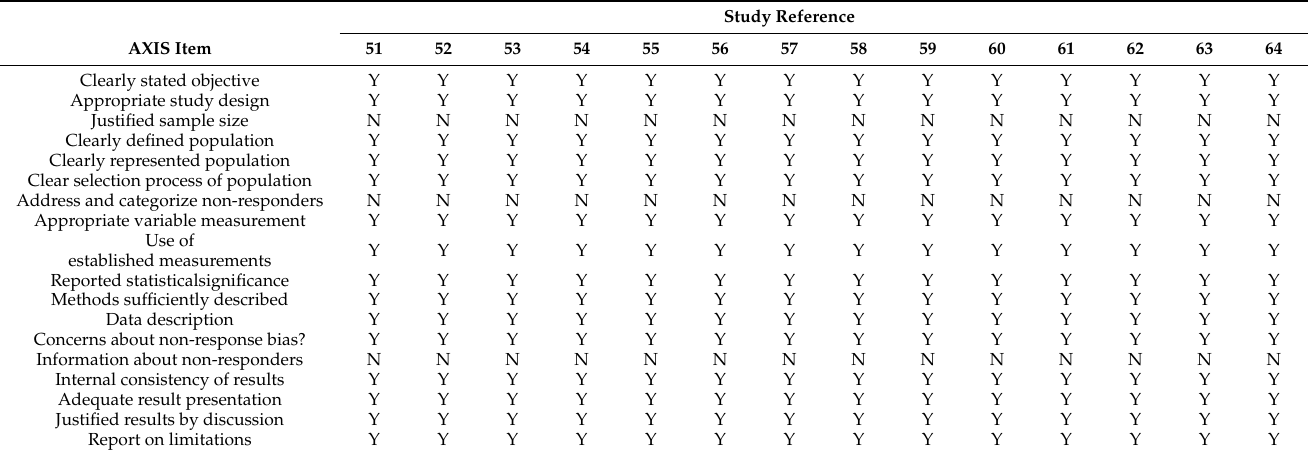
Table 2. Quality assessment of included studies using the AXIS